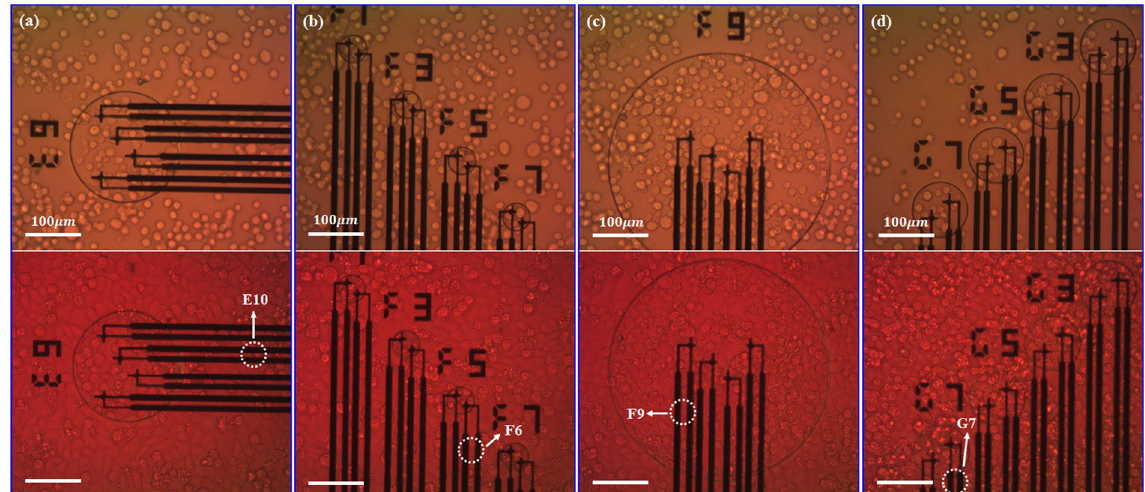
Figure 6. Microscopic images of cultured HepG2 cells. The top panel and bottom panel are photographs taken before and after test, respectively. ( a – d ) The relative positions of adherent HepG2 cells and labelled micro- TFTCs E10, F6, F9 and G7. The live cells show typical irregular shape and light contrast, and the apoptotic cells show round shape and dark